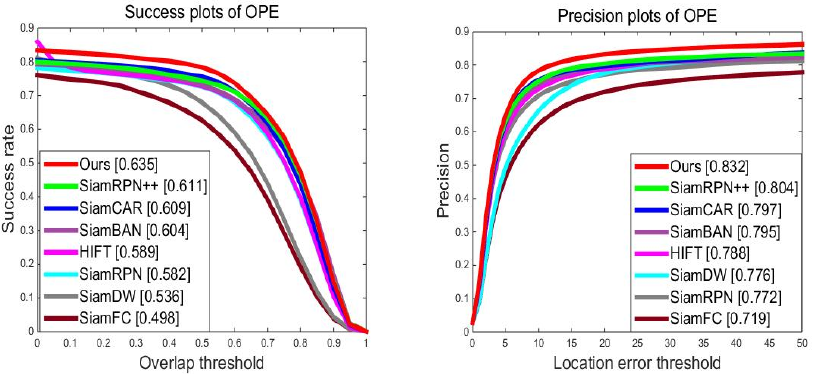
Figure 5. UAV123 comparison chart. The proposed algorithm TR-Siam performs favorably against state-of-the-art trackers. The left is Success plots, the right is Precision plots.